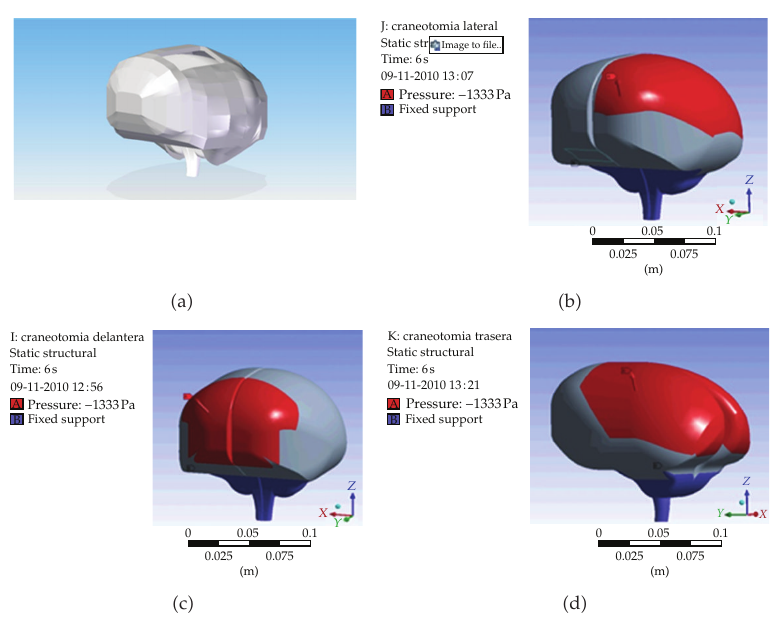
Figure 6: Boundary condition for parietal, frontal, and posterior